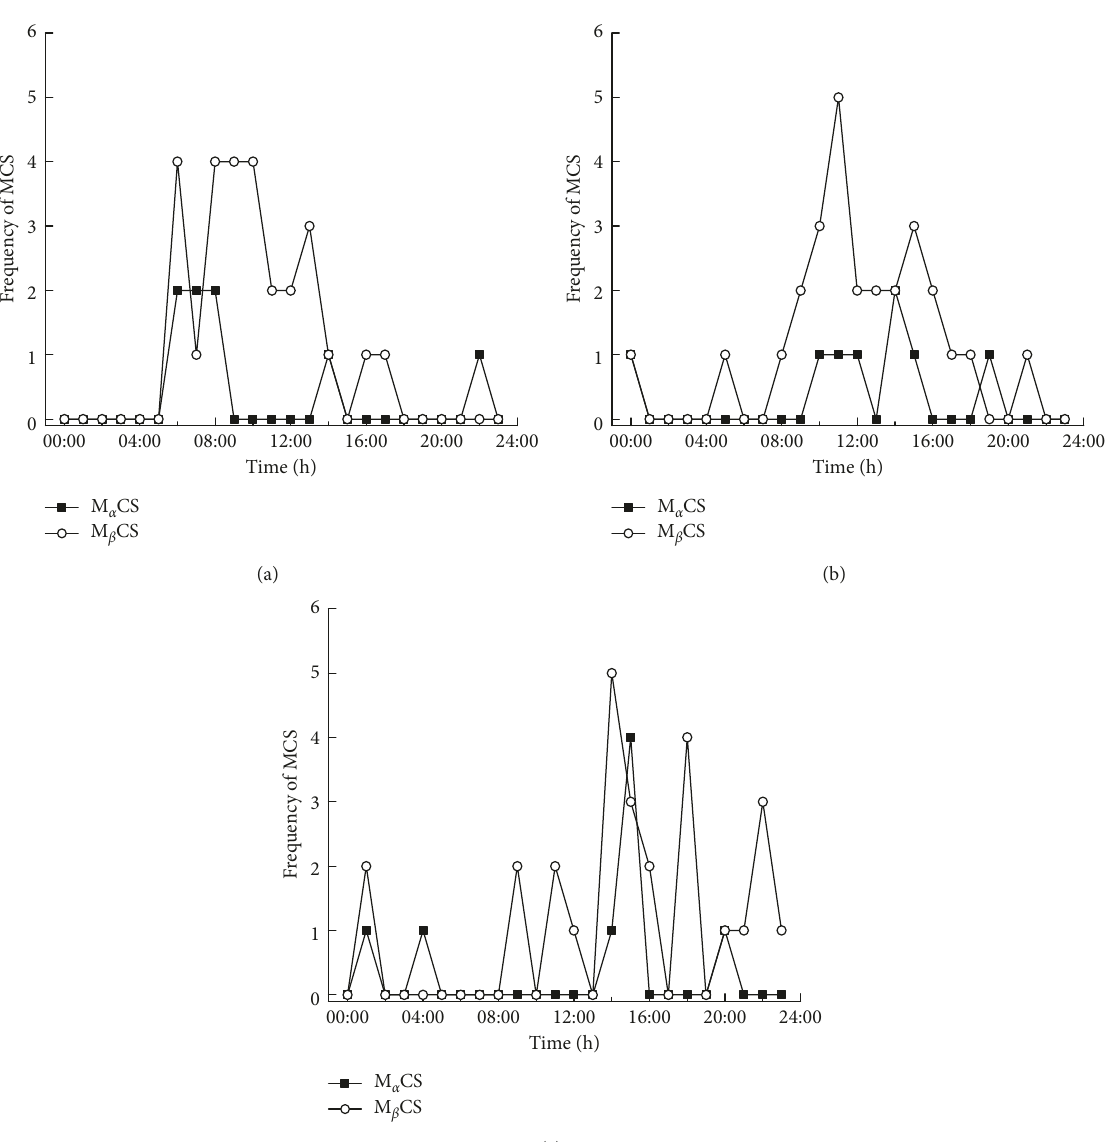
Figure 5: Diurnal frequency distribution of different phases of MCSs: (a) formation; (b) maturity; (c)